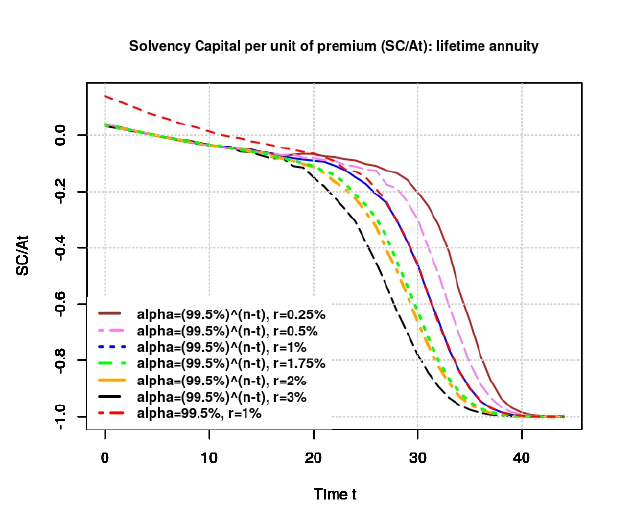
Figure 2. Lifetime annuity; SC ( t ) / A t for different values of the short rate r and α .